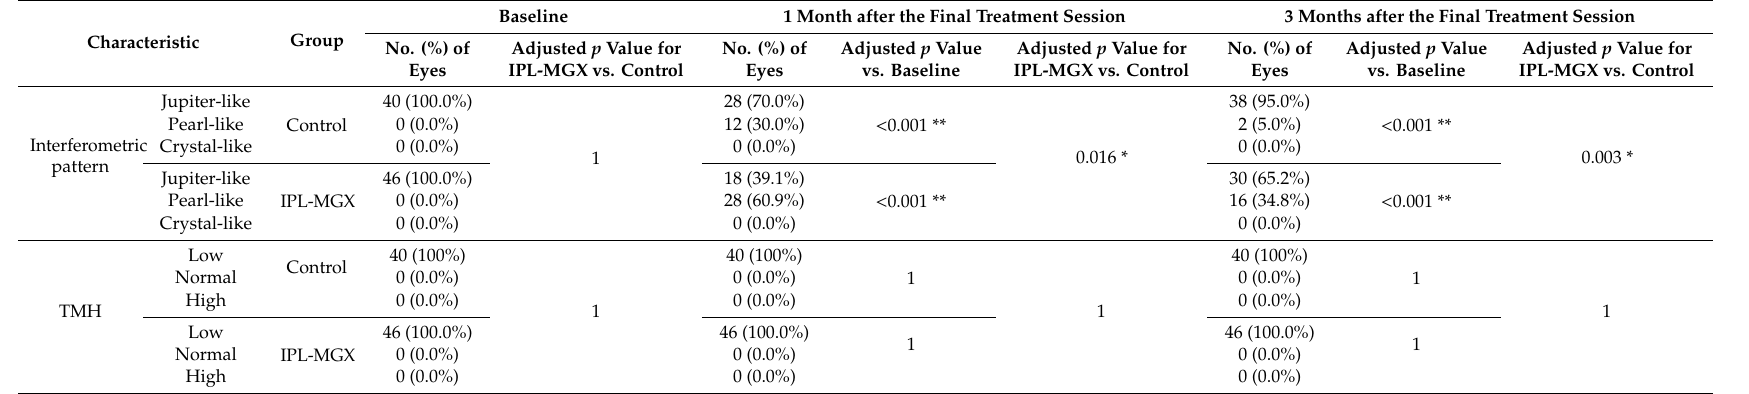
Table 4. Lipid layer grade and tear meniscus height (TMH) of the study subjects with aqueous-deficient dry eye and mild meibomian gland dysfunction in the intense pulsed light (IPL)—meibomian gland expression (MGX) group ( n = 46 eyes) and MGX (control) group ( n = 40 eyes) at baseline as well as 1 and 3 months after the treatment completion.